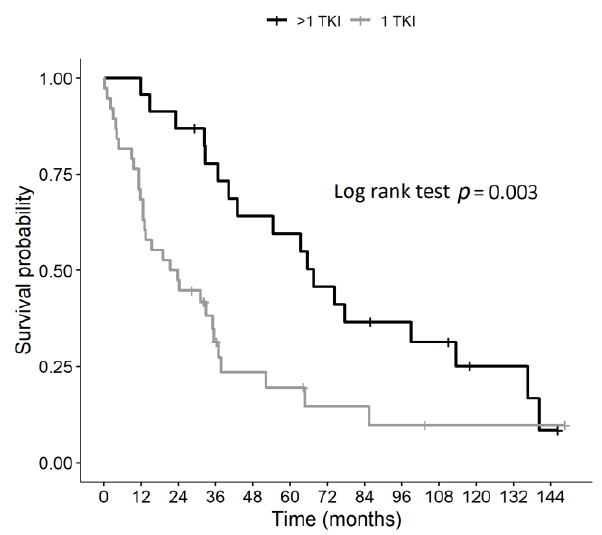
Figure 3. Kaplan–Meier curve of overall survival in Study (>1 TKI) and Control group (1 TKI).